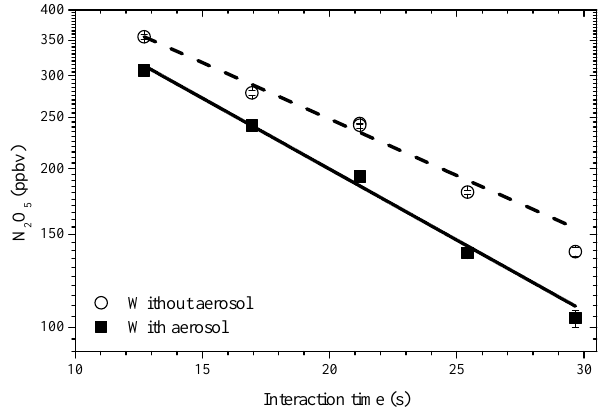
Figure 3. Measured N 2 O 5 mixing ratios at different N 2 O 5 –TiO 2 interaction times, i.e. at different injection positions, with (solid squares) and without (open circles) TiO 2 aerosols in the flow tube. The pseudo-first-order decay rates of N 2 O 5 are 0.0493 ± 0.0025 and 0.0619 ± 0.0030s − 1 without and with TiO 2 aerosols in the flow tube,